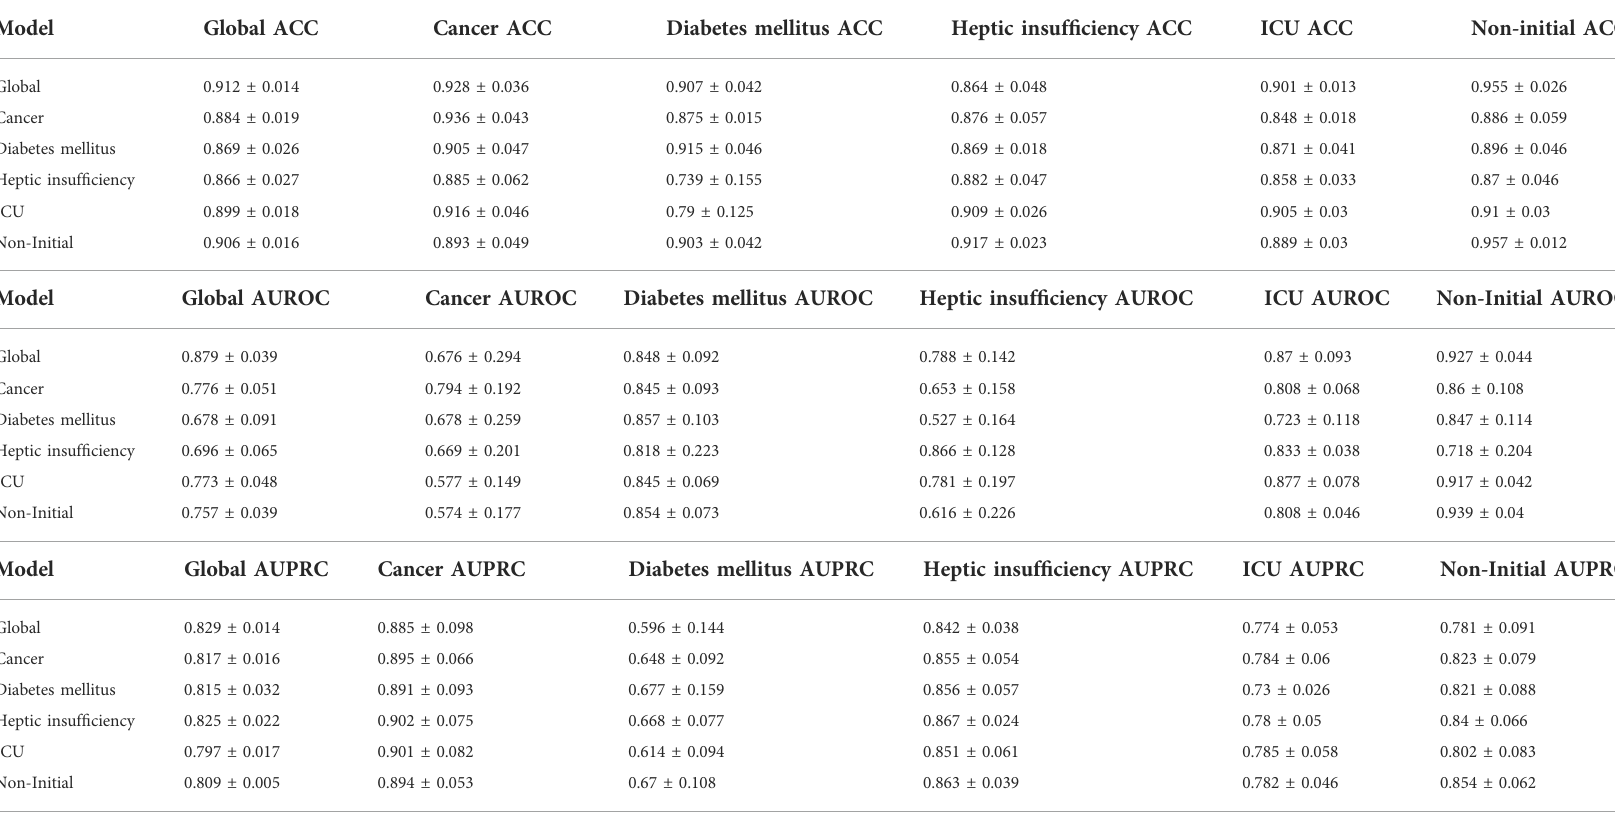
TABLE 2 The ACC, AUROC, and AUPRC of global model and